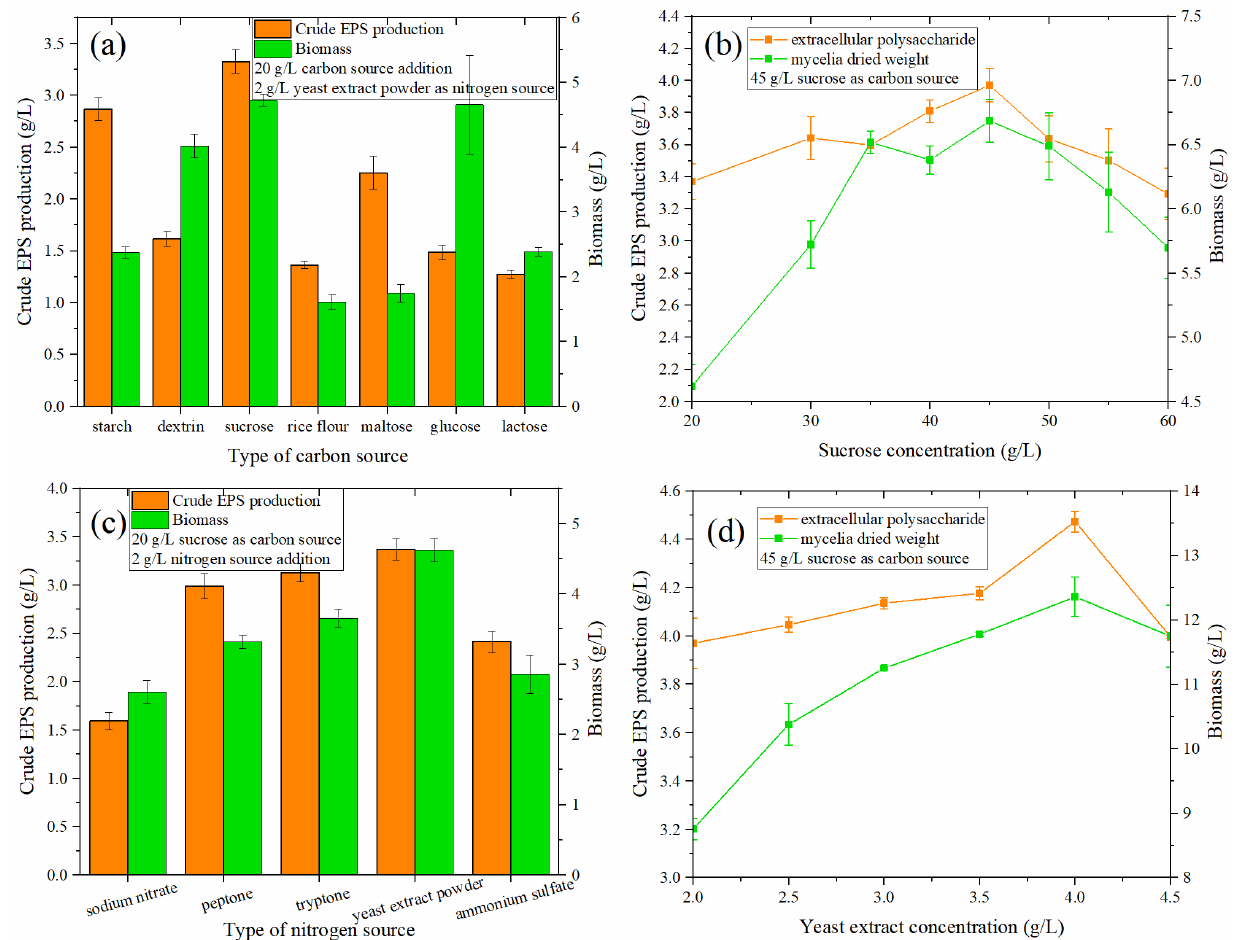
Figure 2. ( a ) Effect of carbon source type on the crude EPS production and biomass of MAL . ( b ) Effect of sucrose concentration on crude EPS and biomass produced by MAL . ( c ) Effect of nitrogen source type on the crude EPS production and biomass of MAL . ( d ) Influence of yeast extract concentration on the crude EPS and biomass produced by MAL .